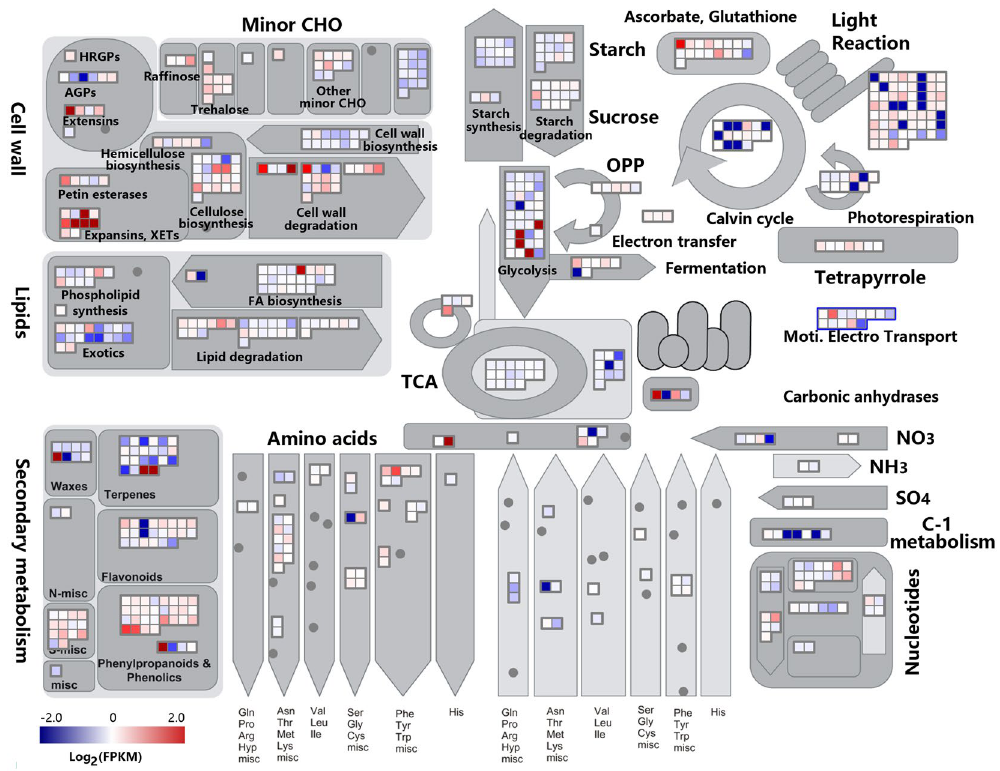
Figure 6. A schematic overview of changes in transcript abundance in the middle internode compared to the upper internode. The log2 transformed FPKM values were imported into MapMan software to generate the overview of general metabolism in the middle internode (MI) compared to the upper internode (UI). DEGs are represented by colored squares and grouped according to functional annotation based on MapMan ontology. The fold change of DEGs is indicated by the scale bar. Red indicates up-regulation, whilst blue indicates down-